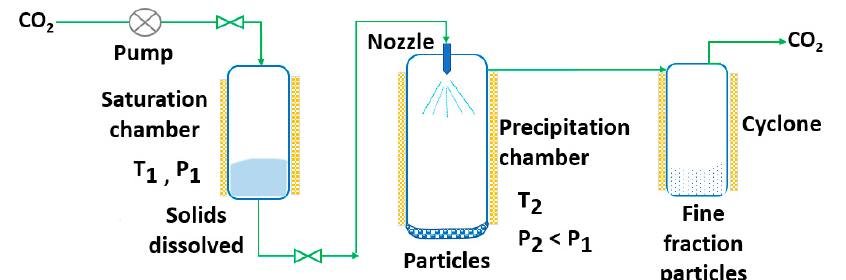
Figure 4. Particles from gas-saturated solutions (PGSS) process (adapted from Martin and Cocero [123]).